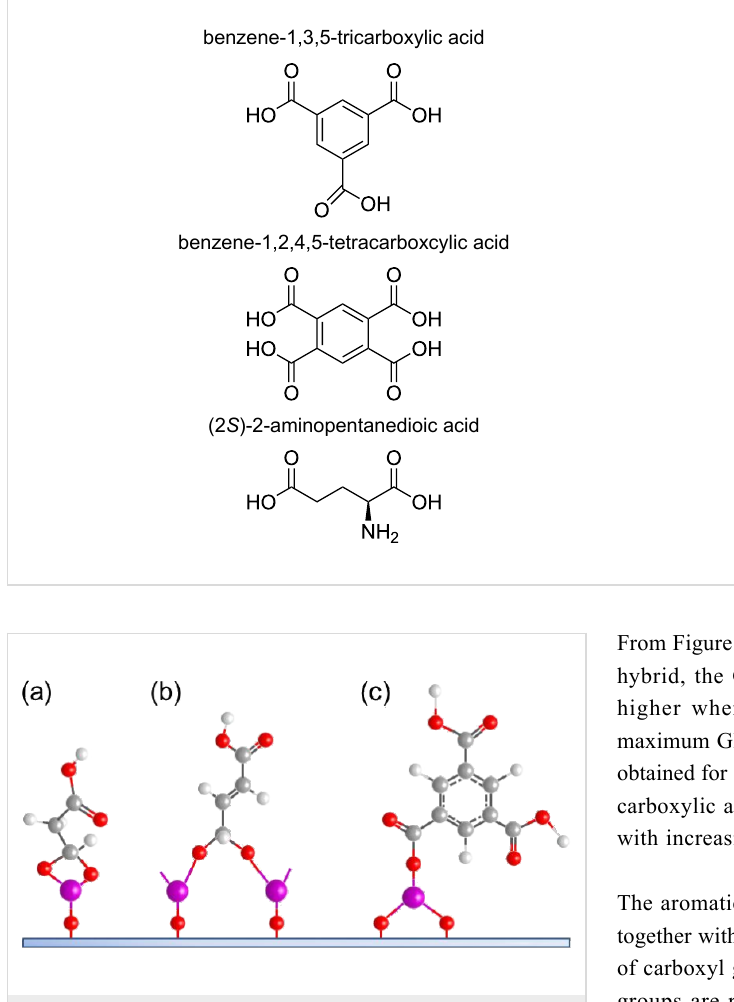
Figure 7: Schematic illustration of ALD/MLD inorganic–organic hybrid thin films deposited using TMA together with (a) propanedioic acid (bidentate complex), (b) ( E )-butenedioic acid (bridging complex), and (c) benzene-1,3,5-tricarboxylic acid (unbidentate